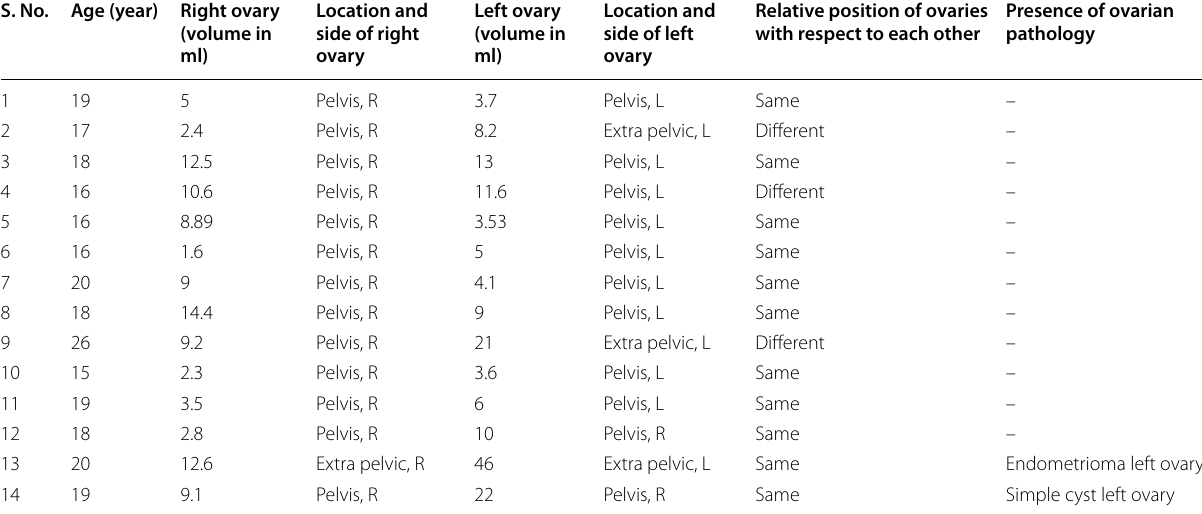
Mean volume of right ovary was 7.42 ml Mean volume of left ovary was 11.909 ml